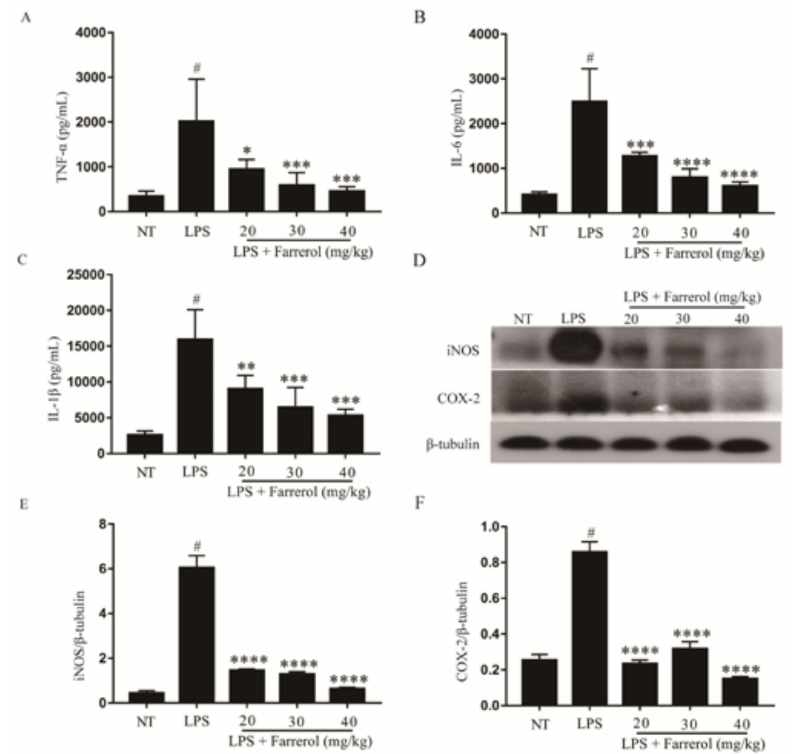
Figure 4. The levels of TNF- α ( A ); IL-6 ( B ) and IL-1 β ( C ) in the homogenate of mouse mammary glands including NT group, LPS group and LPS + farrerol (20, 30, 40 mg/kg) group; The protein levels of iNOS ( D , E ) and COX-2 ( D , F ) were measured by Western blot. Data are presented as mean ± SEM